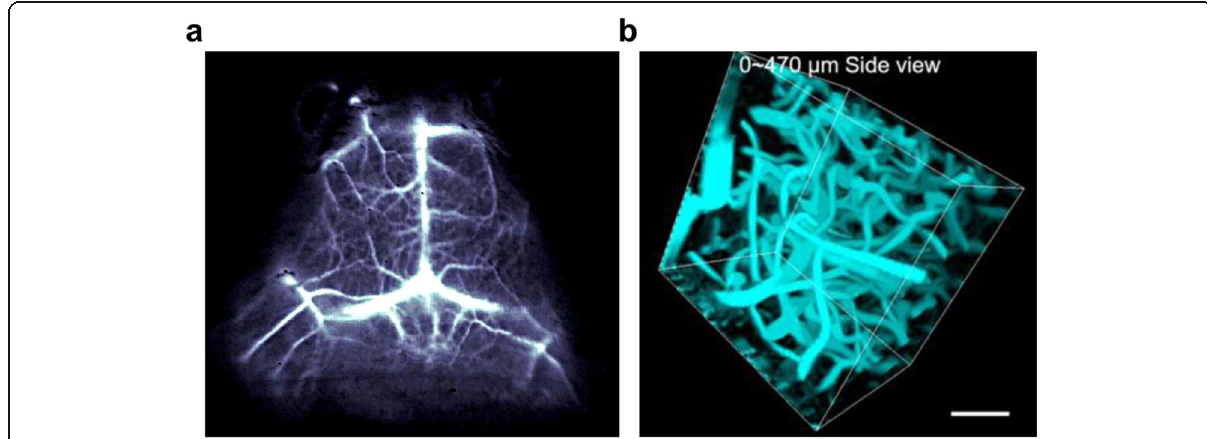
Fig. 6 Modality of NIR-IIb fluorescent optical imaging. a In vivo mouse brain vessel imaging using a cerium-doped rare earth nanoparticle. b 3D reconstruction of cerebral blood vessels of the rhesus macaque based on ICG-mediated NIR-II fluorescence confocal microscopic in vivo imaging up to depth of 470 μ m. Adapted with permission from Zhong et al. 2017 ( a ) and from Cai et al. 2020 ( b